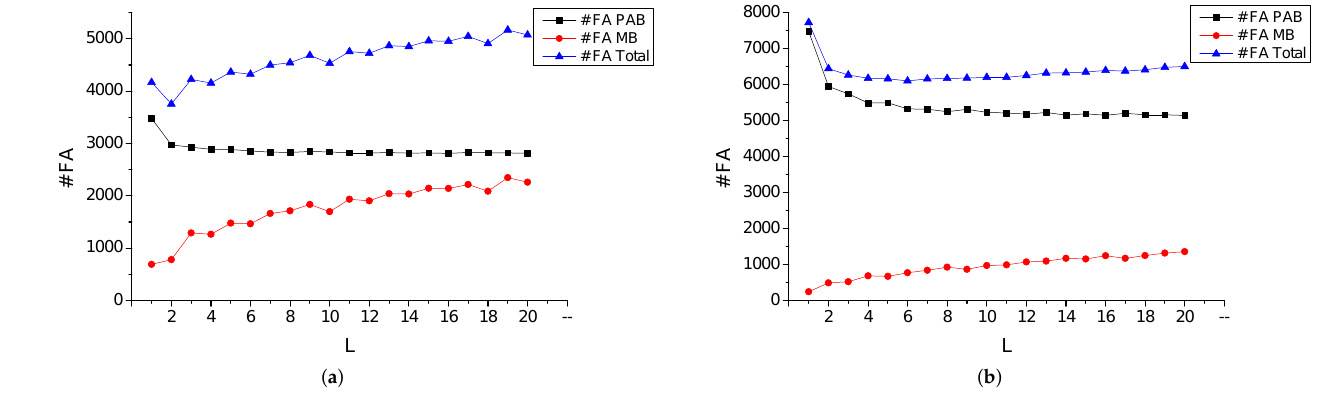
Figure 8. Full adder cost of ( a ) filter A and ( b ) filter B for different L